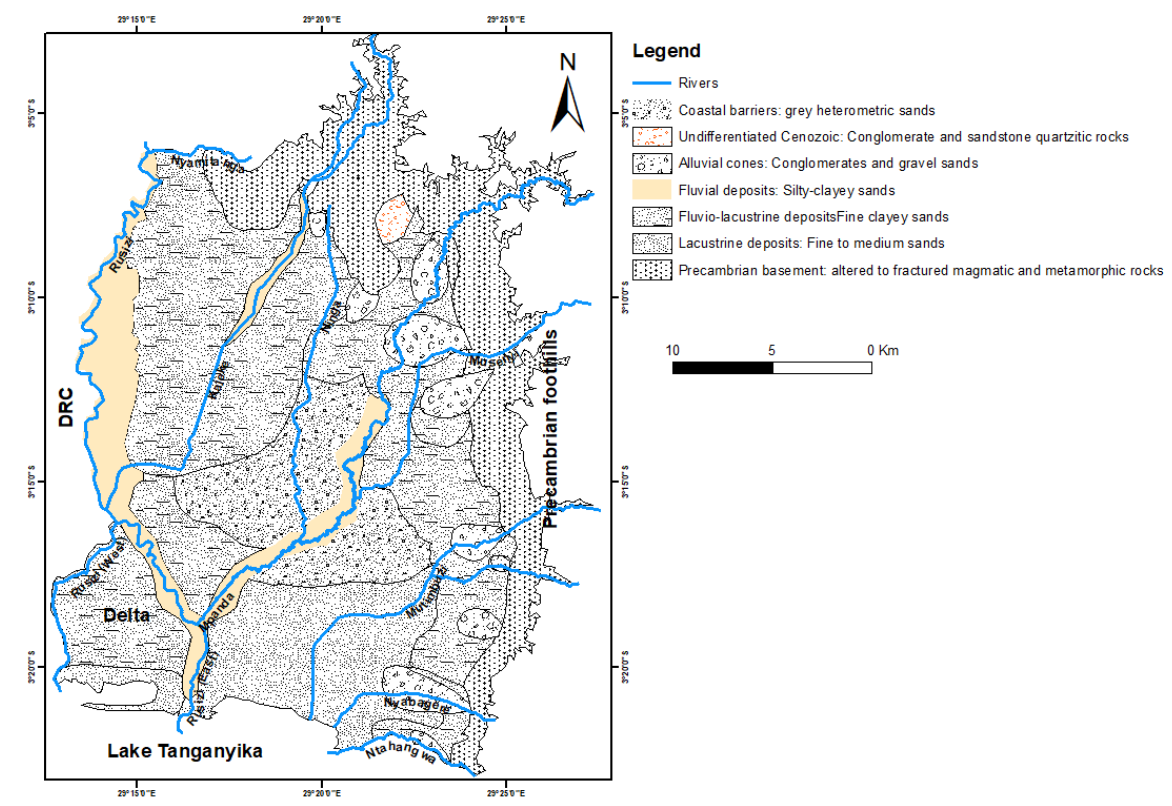
Figure 2. Sedimentological sketch of the aquifer in the lower Rusizi plain. Figure 3. Sedimentological sketch of the aquifer in the lower Rusizi plain.